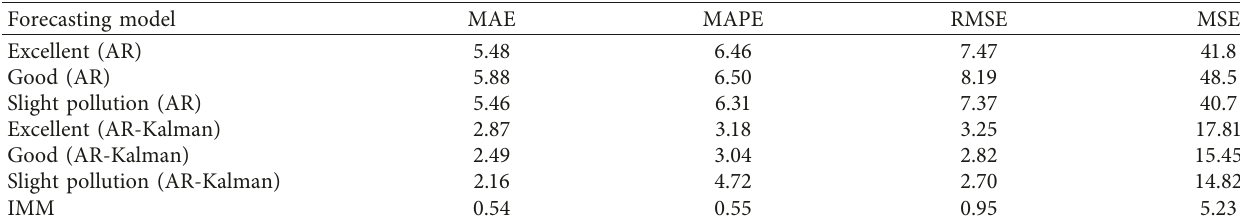
2.5 concentration.